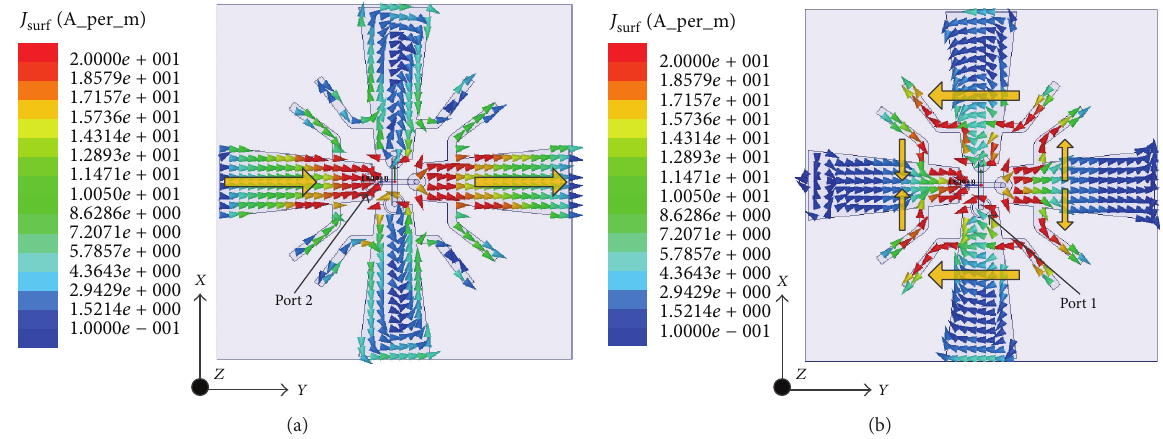
Figure 4: Current distribution of the proposed antenna at (a) 2.5 GHz and (b) 3.6 GHz for Port 2.